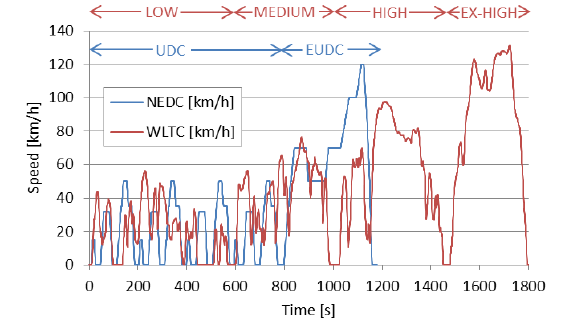
Fig. 1. Speed profile for WLTC and NEDC